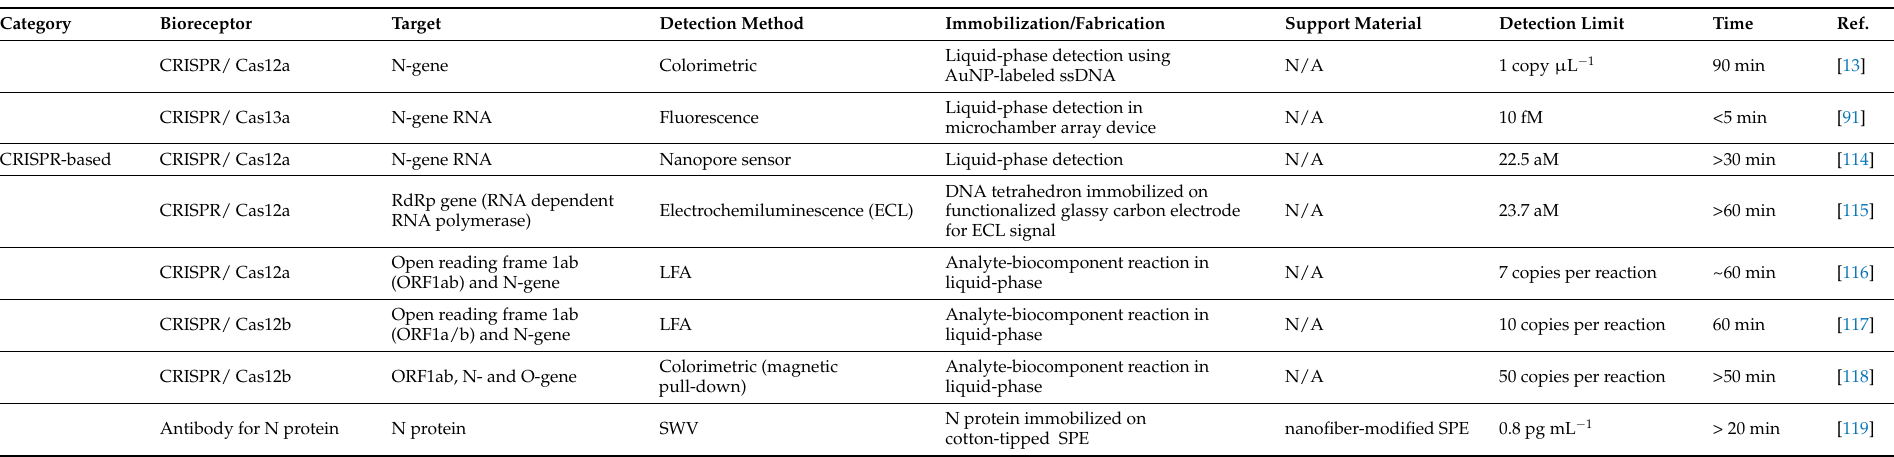
Table 2. List of some recently reported sensing systems for